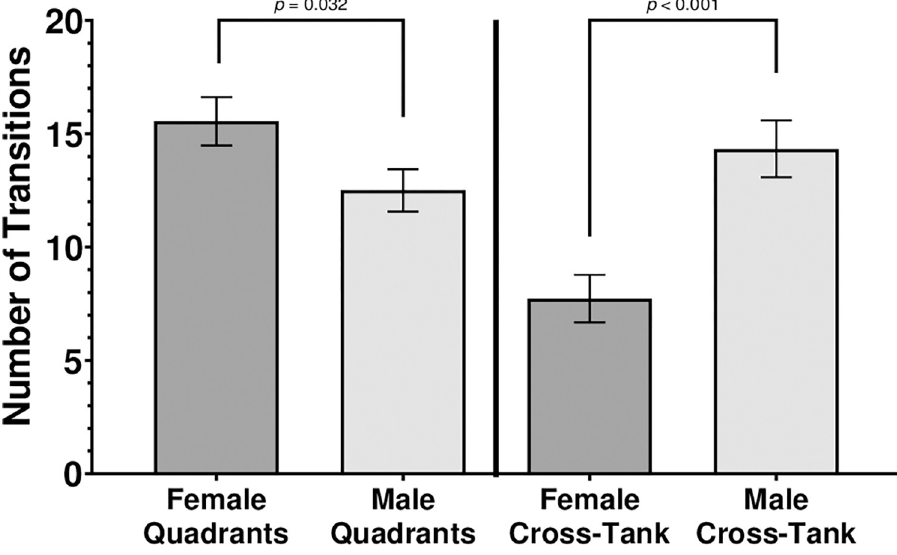
Fig 6. Sex differences in inter-quadrant and cross-tank transitions. Quadrants of the subject tank were labeled by upper/lower sections of the tank and novel/established stimulus shoal proximity. Error bars are +/- SEM. While exact p- values are reported for post-hoc comparisons, p- values smaller than 0.001 are indicated as p < 0.001.